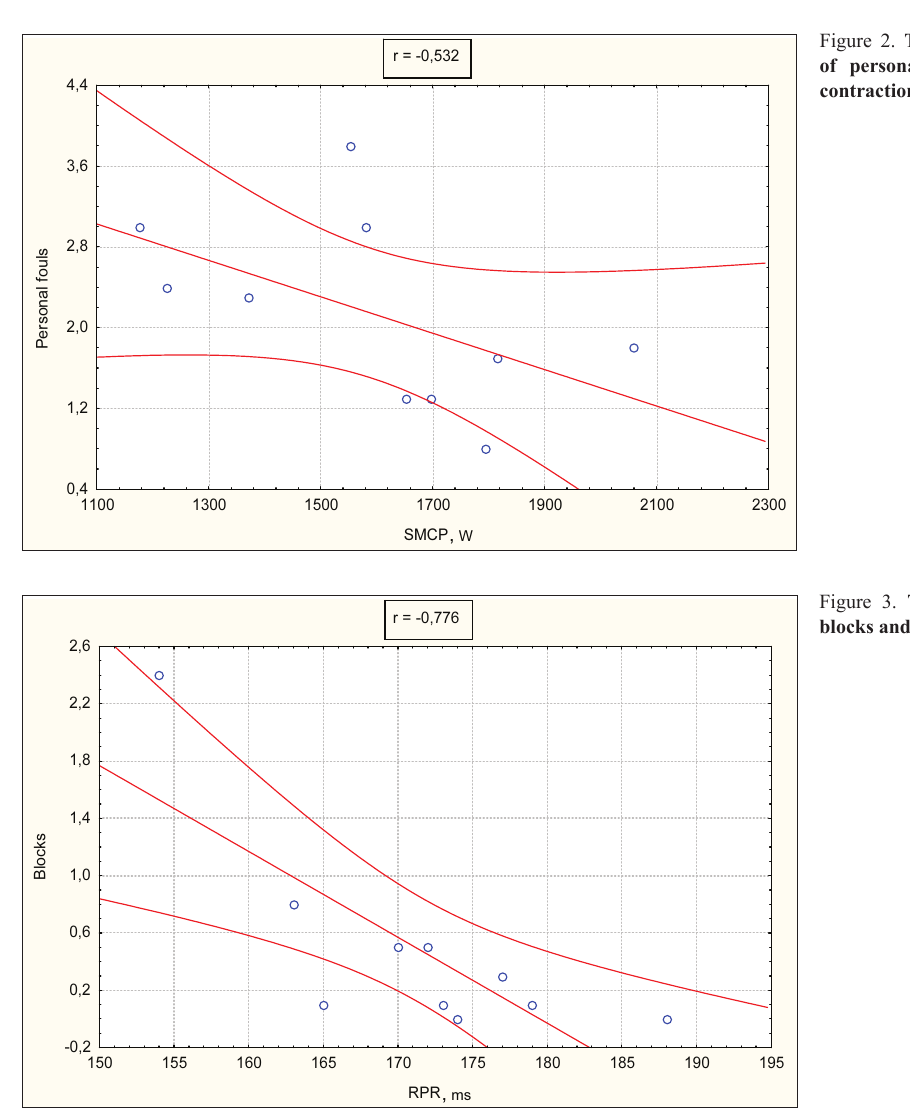
Figure 3. The correlation of number of blocks and psychomotor response time